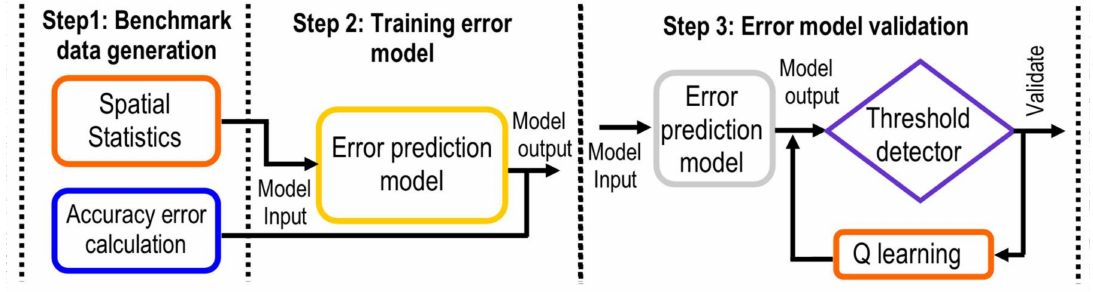
Figure 3. Overall scheme of the methodology of the self-tuning